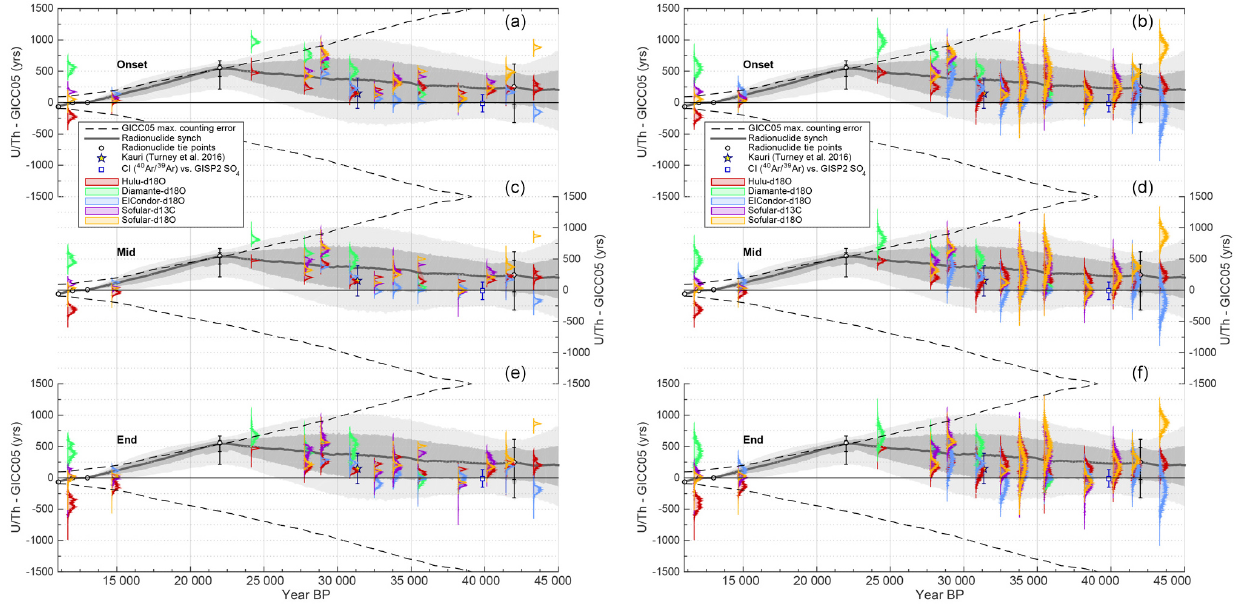
Figure 14. Timing differences of the onset (a, b) , midpoint (c, d) , and end (e, f) of rapid climate changes in NGRIP and speleothems (colored PDFs; see legend) and the timescale transfer function inferred from radionuclide matching (black line and grey shadings as in Fig. 12). (a, c, e) The PDFs of timing differences including only uncertainties from the determination of the change points in the climate records; panels (b, d, f) also include the speleothem dating